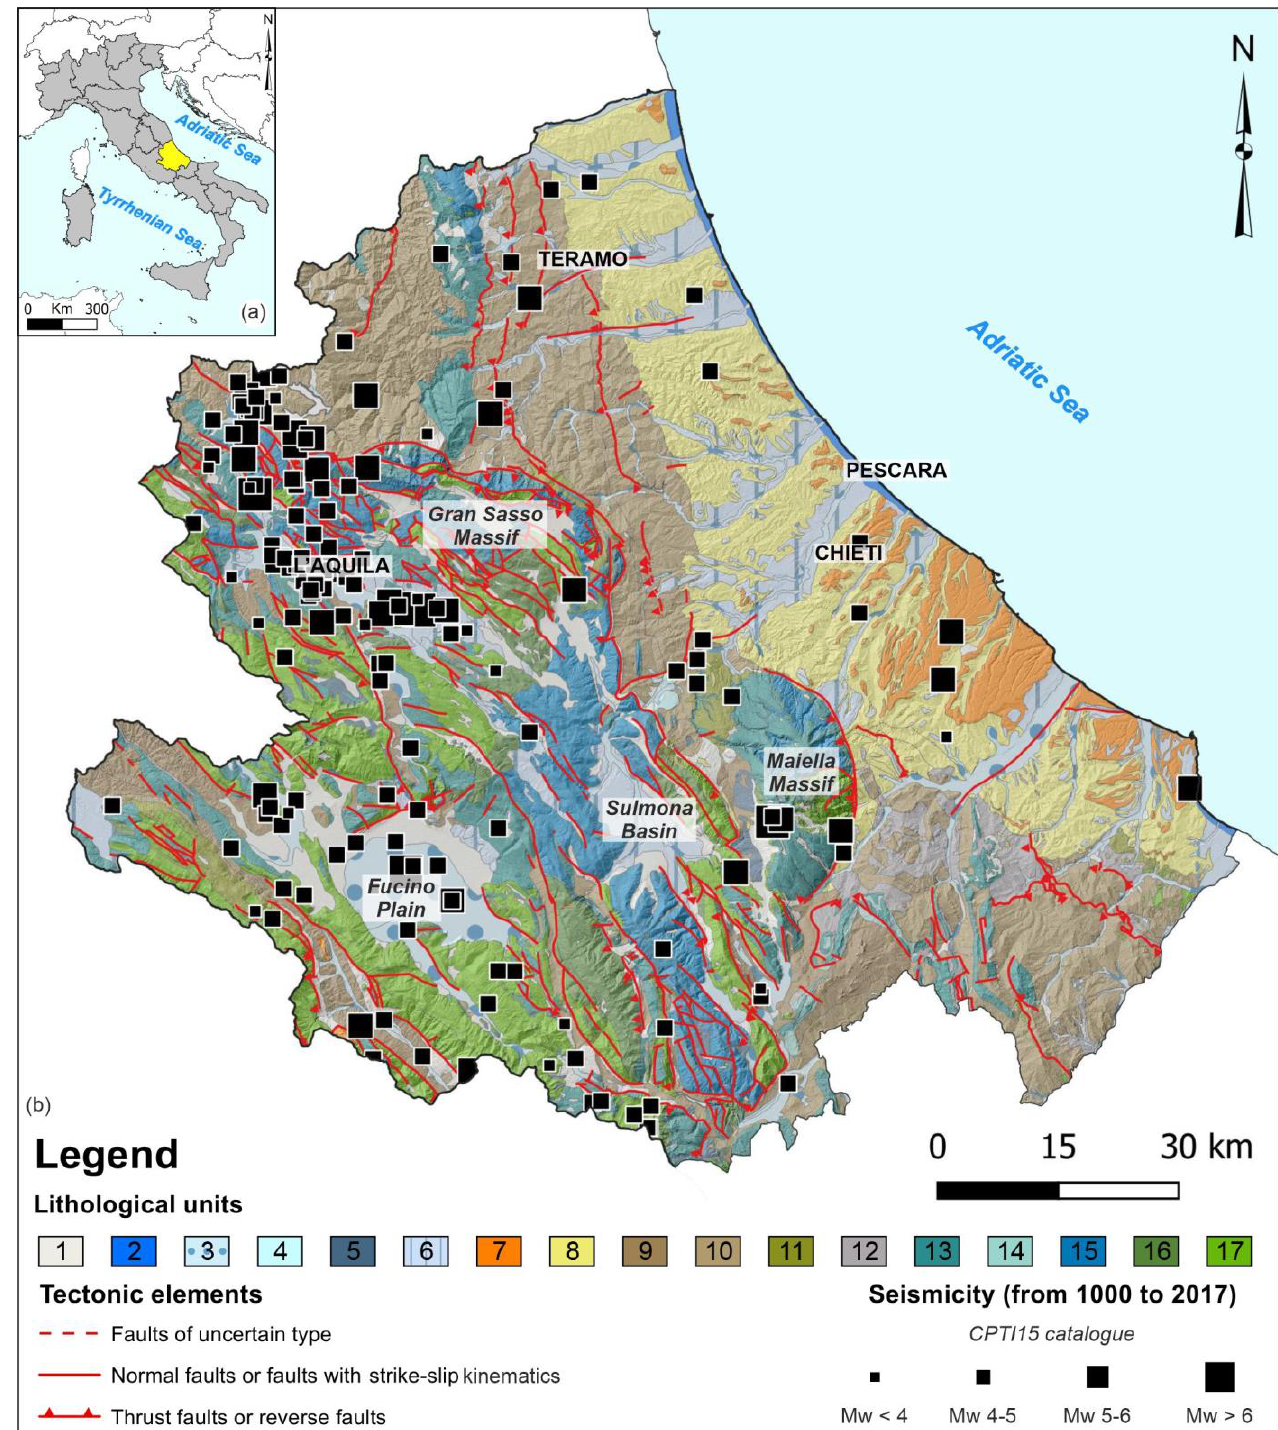
Figure 1. ( a ) Location map of the Abruzzo Region in Central Italy; ( b ) geolithological map of the Abruzzo Region (modified from [56,57]). Legend: (1) eluvial–colluvial deposits; (2) sandy shore deposits; (3) recent fluvio-lacustrine deposits; (4) travertine deposits; (5) morainic deposits; (6) old fluvio-lacustrine deposits; (7) conglomeratic deposits; (8) clayey–sandy deposits; (9) sandy turbidites; (10) pelitic turbidites; (11) carbonate deposits in conglomeratic and calcarenitic facies; (12) allochthonous pelagic deposits; (13) carbonate ramp limestones; (14) basin limestones and marls; (15) slope limestone; (16) open carbonate shelf-edge limestones; (17) carbonate shelf limestones and dolomites. Seismicity derived from [49].